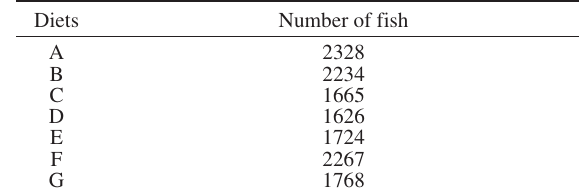
Table 6. – Number of fish that can be produced for a target size of 30 cm with a given budget of €1000. Daily mortality was assumed to be 0.012%. Diets Number of